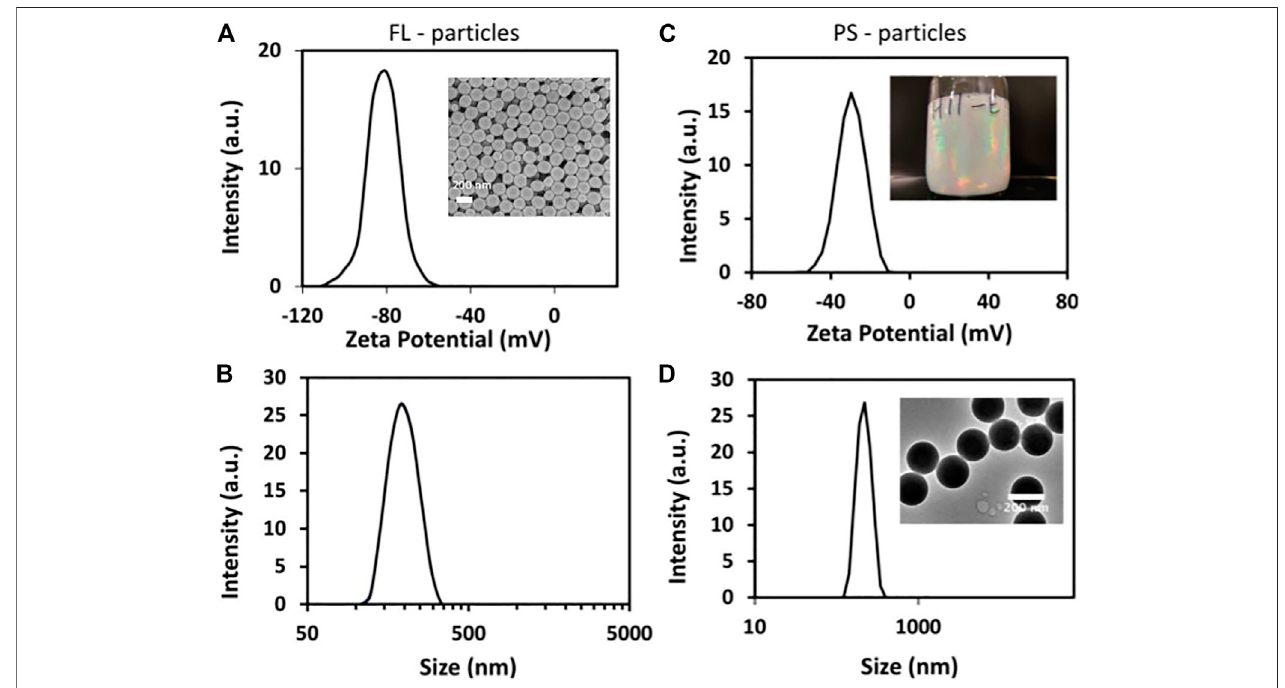
FIGURE 1 | (A) Zeta-potential measurement of the synthesised FL particles suspended in 10 mM phosphate buffer. The inset shows an SEM image of the dried particles. (B) Size distribution of the FL particles measured using DLS. (C) Zeta-potential measurement of the PS particles suspended in 10 mM phosphate buffer. The inset shows a photograph of these PS particles after synthesis and washing. The particle content is roughly 2 % , but the strongly scattering dispersion still shows iridescent colours. (D) Size distribution of the PS particles measured using DLS. The inset shows a TEM micrograph of the dried PS